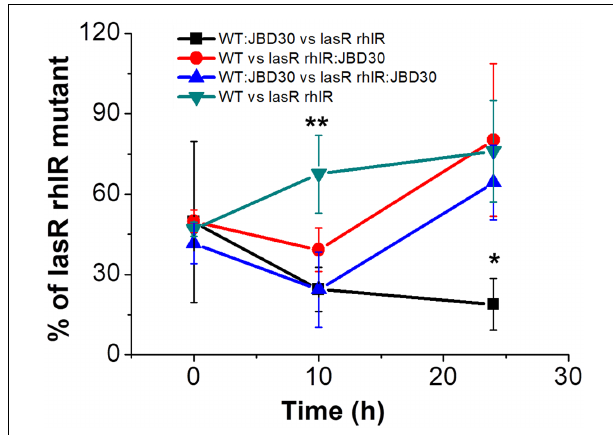
FIGURE 3 | Lysogenic wild-type strain for the phage JBD30 restricts the survival of lasR rhlR mutants in M9 caseinate medium. Competitions were done in triplicate (averages are shown). WT:JBD30 and lasR rhlR :JBD30 correspond to the lysogenic versions of JBD30 for the strains indicated. The outcome of the competition of WT lysogenized by JBD30 is different from the outcomes of the other three competitions at 24 h ( ∗ ), P < 0.05 in a two-tailed Student’s t -test, and the proportion at 10 h of the competition without lysogens was different from all the other competitions at the same time ( ∗∗ ) P < 0.05 in a two-tailed Student’s t -test.